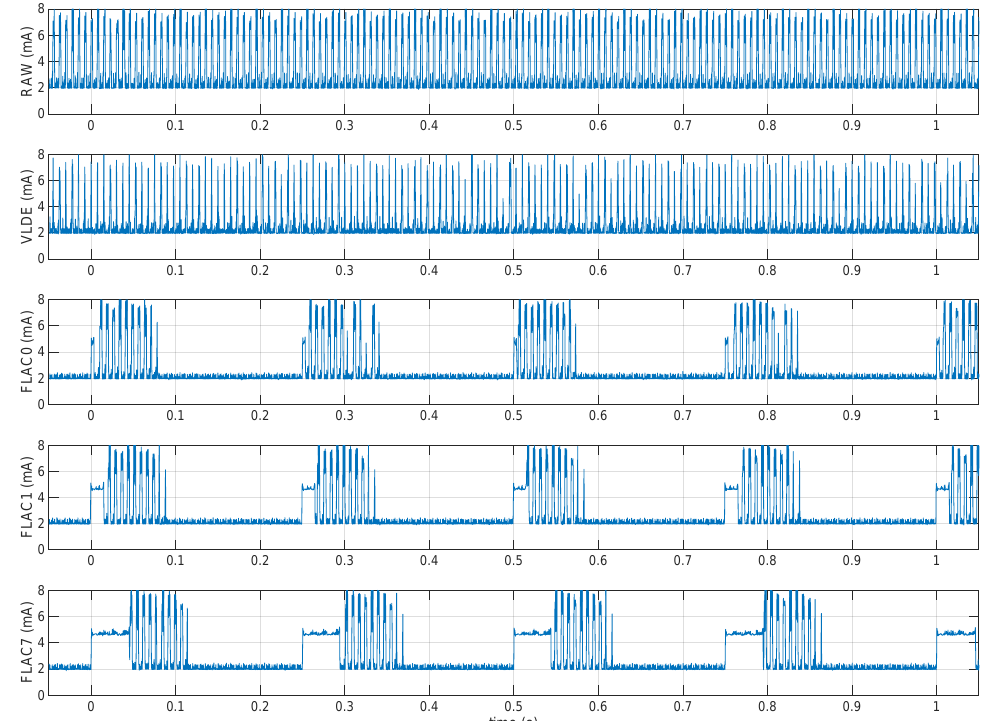
Figure 10. Current consumption of different compression algorithms. The top strip actually represent uncompressed (raw) data streaming. On average, 3 packets per connection event are transmitted. The other strips are for 20bit per sample compressors, starting from VLDE. It has the same connection event density as the raw data, but it only needs to transmit 1 or 2 packets per connection event (1.5 on average since it compresses about 50%). Next we have FLAC at various levels: after an initial CPU time due to block compression, the software was set to transmit up to 4 packets per connection event, so there is ample radio idle time between bursts. Since the block size was set at 200 and the sample rate is 800Hz, we have one burst every 250ms.